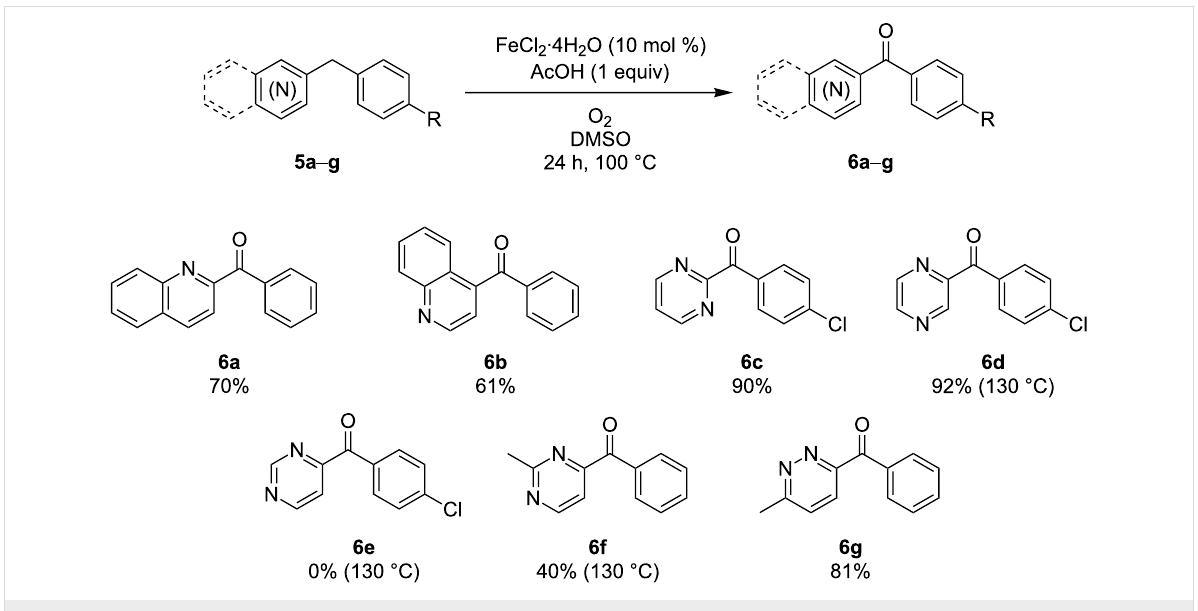
Scheme 1: Benzylic oxygenation of benzoannulated azines and diazines ( 5